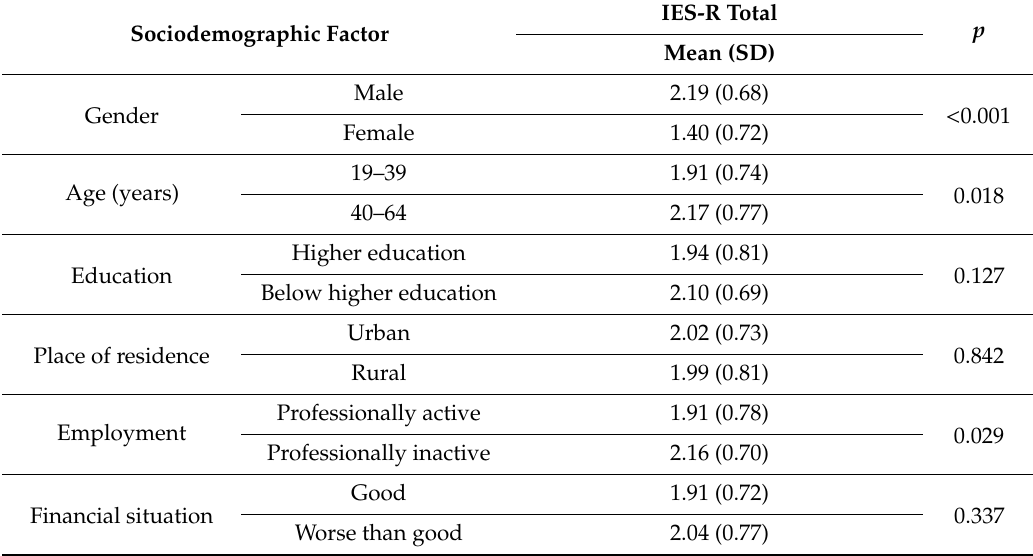
Table 3. Comparison of Impact of Event Scale-Revised (IES-R) results by sociodemographic factor. Sociodemographic